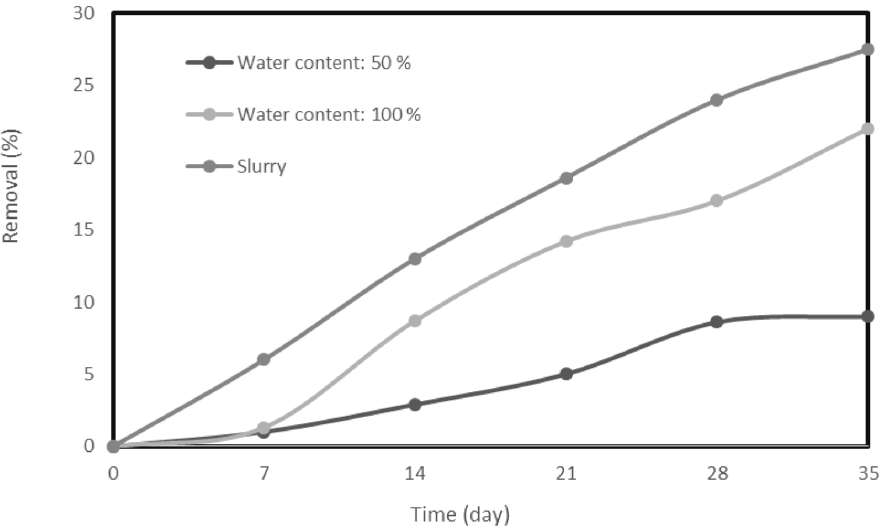
Fig. 3 – Effect of water content on n-hexadecane biodegradation in synthetically con- taminated soil, initial seed volume: 15 mL, and salinity: 0.5